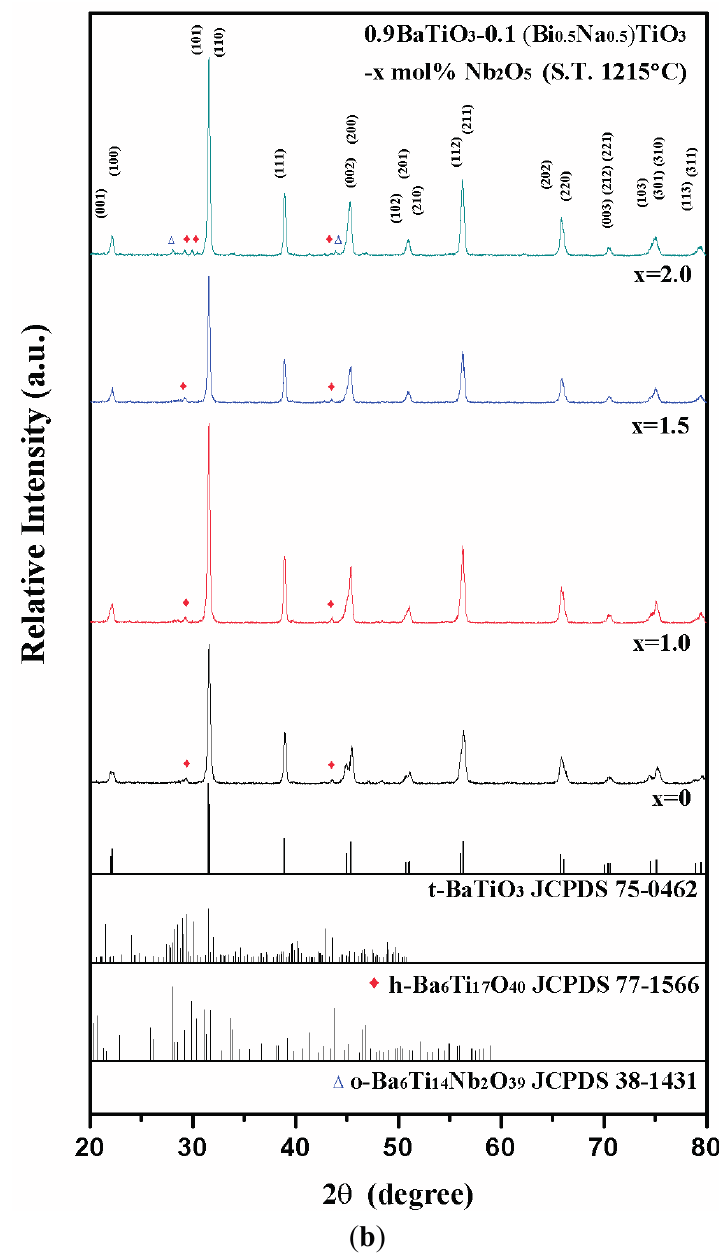
Figure 2. XRD patterns of 0.9BaTiO 3 –0.1(Bi 0.5 Na 0.5 )TiO 3 ceramics with various amounts of ( a ) Ta 2 O 5 and ( b ) Nb 2 O 5 sintered at 1215 °C for 2 h.